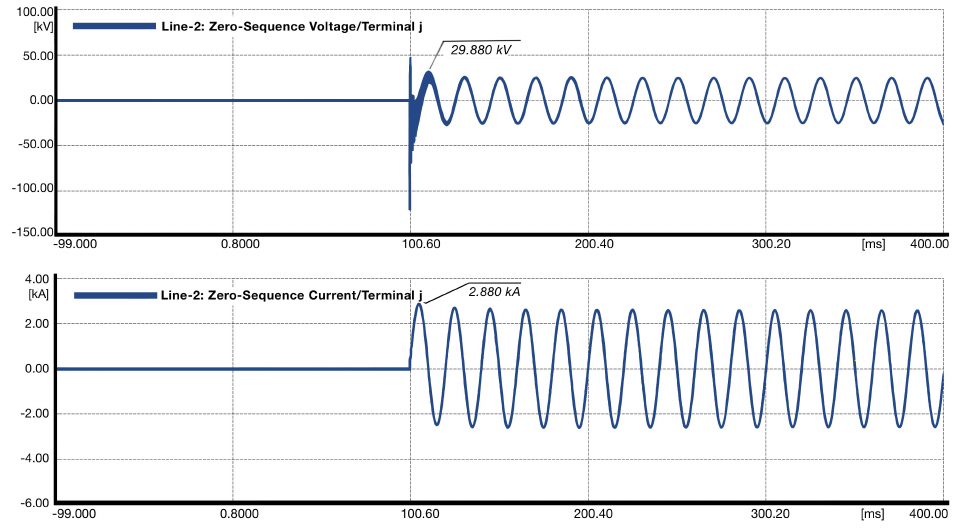
Figure 6. Zero-sequence voltage and current for a single phase–ground